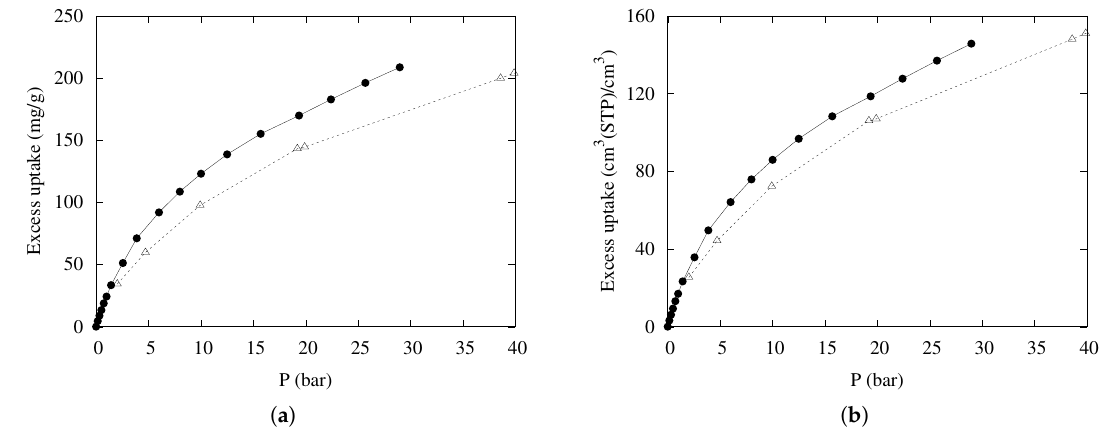
Figure 9. Excess adsorption isotherms at 298 K for CH 4 on a ( a ) mass basis and a ( b ) volume basis in KPS-1 (solid circles) and LMA738 (open triangles)